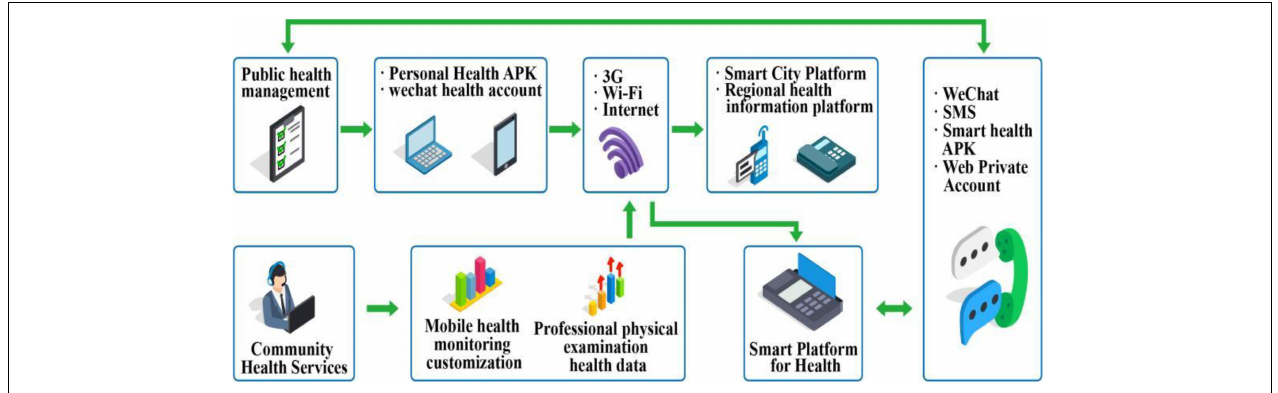
FIGURE 1 | Online community medical